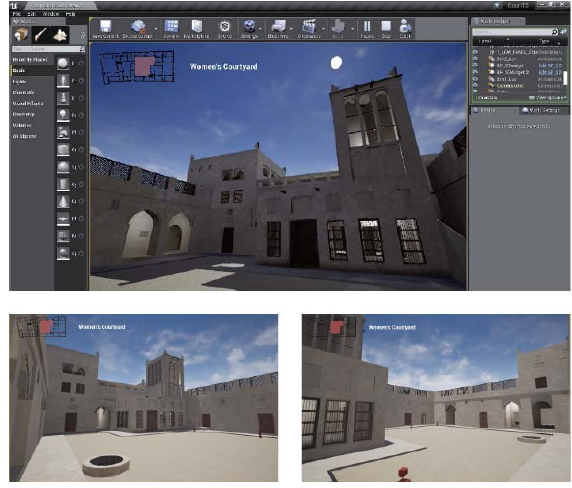
Figure 11. The EU4 VR project based on a detailed